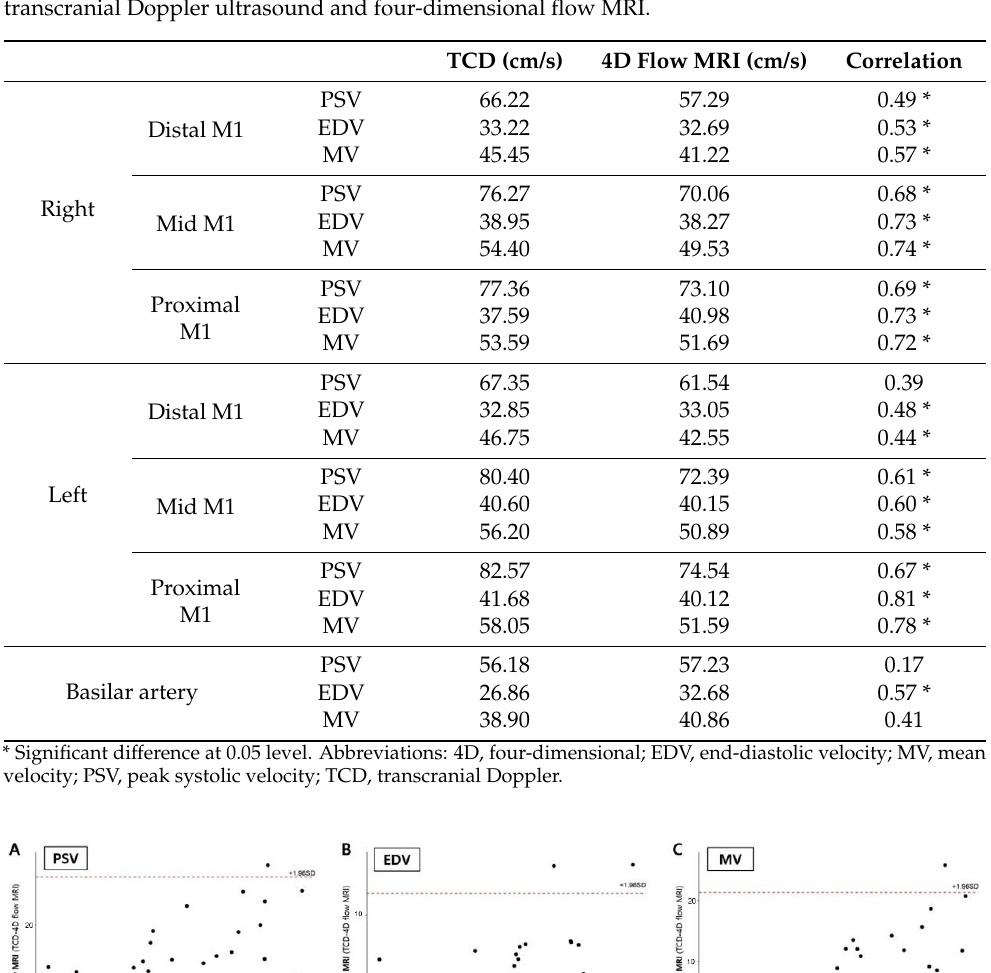
Table 1. Mean of peak systolic velocity, end-diastolic velocity, and mean velocity measured by transcranial Doppler ultrasound and four-dimensional flow MRI.